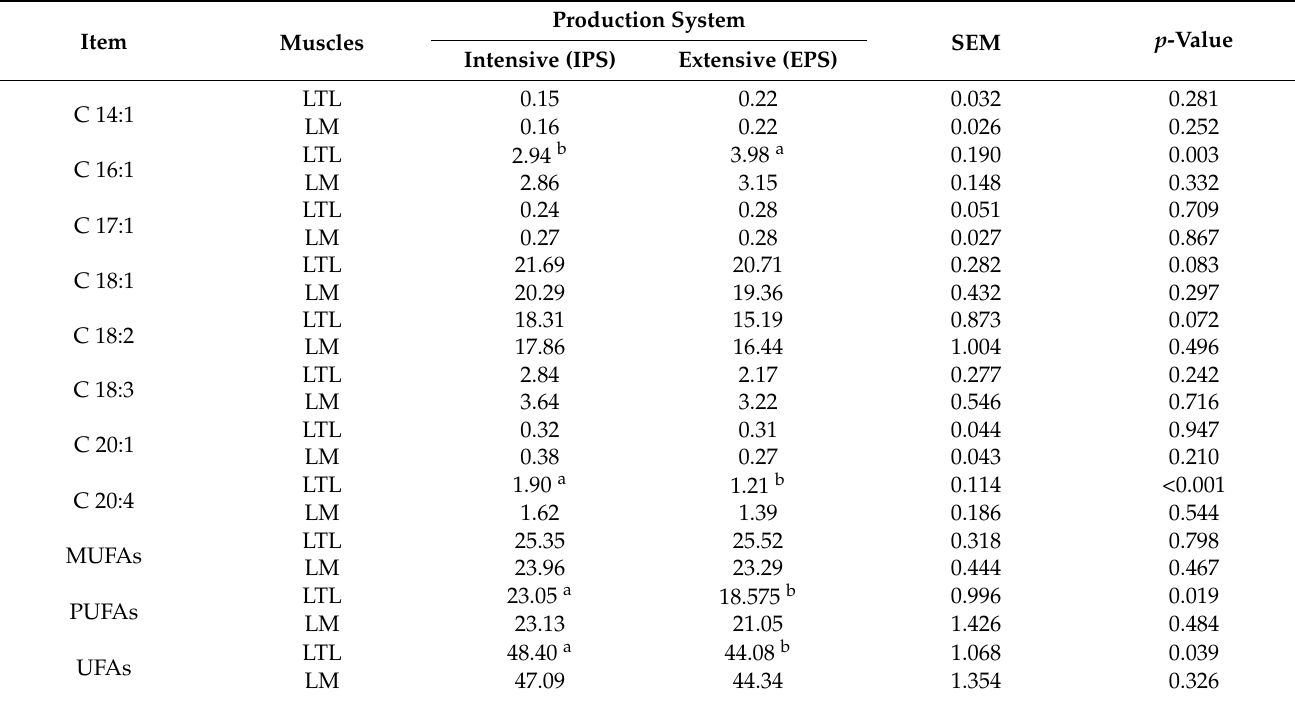
Table 3. Unsaturated fatty acid profile of intramuscular fat in the Longissimus thoracis et lumborum (LTL) muscle and leg muscles (LM) of New Zealand White rabbits.